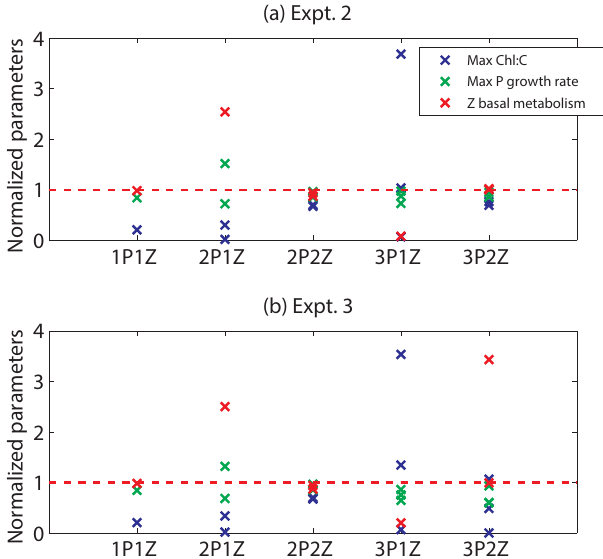
Figure 4. Optimized parameter values normalized to a priori values obtained (a) by assimilating POC and size-fractionated data at the four DA sites (experiment 2), and (b) by assimilating satellite data to which 20% random noise has been added (experiment 3).